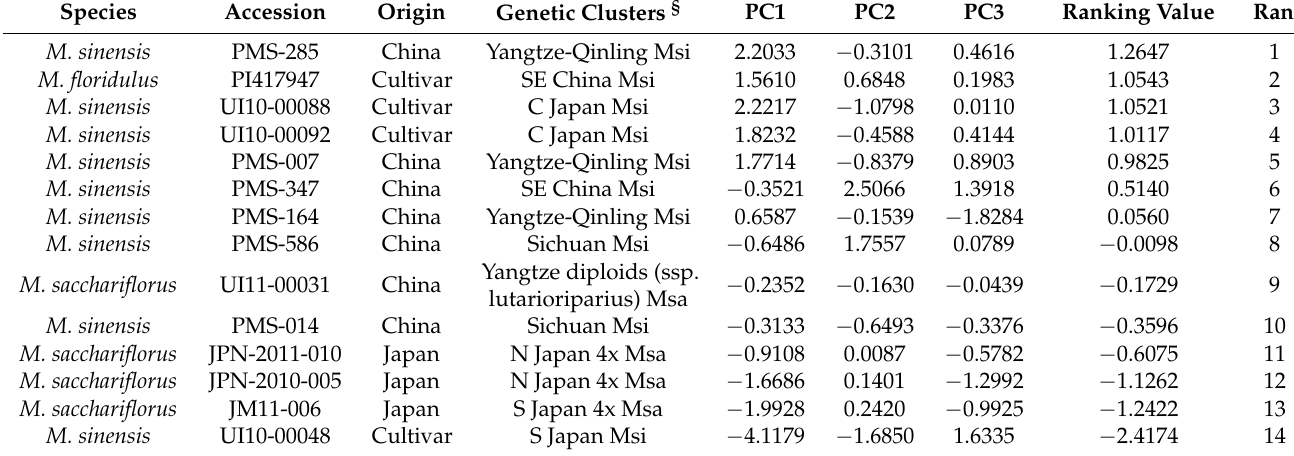
Table 5. Principal components analysis (PCA) ranking values † based on the drought stress index (Day 14) and the rank of drought-tolerance capacity of fourteen Miscanthus genotypes under slight drought stress ‡ in a screening experiment at Brigham Young University (BYU), Provo, Utah, USA.